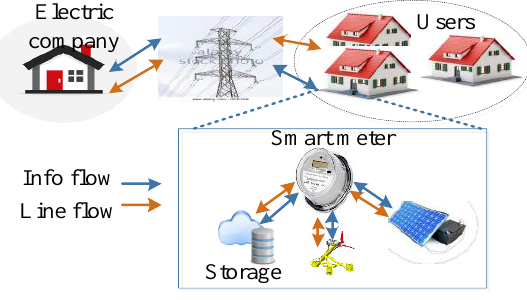
Figure 20. Power delivery system overview.